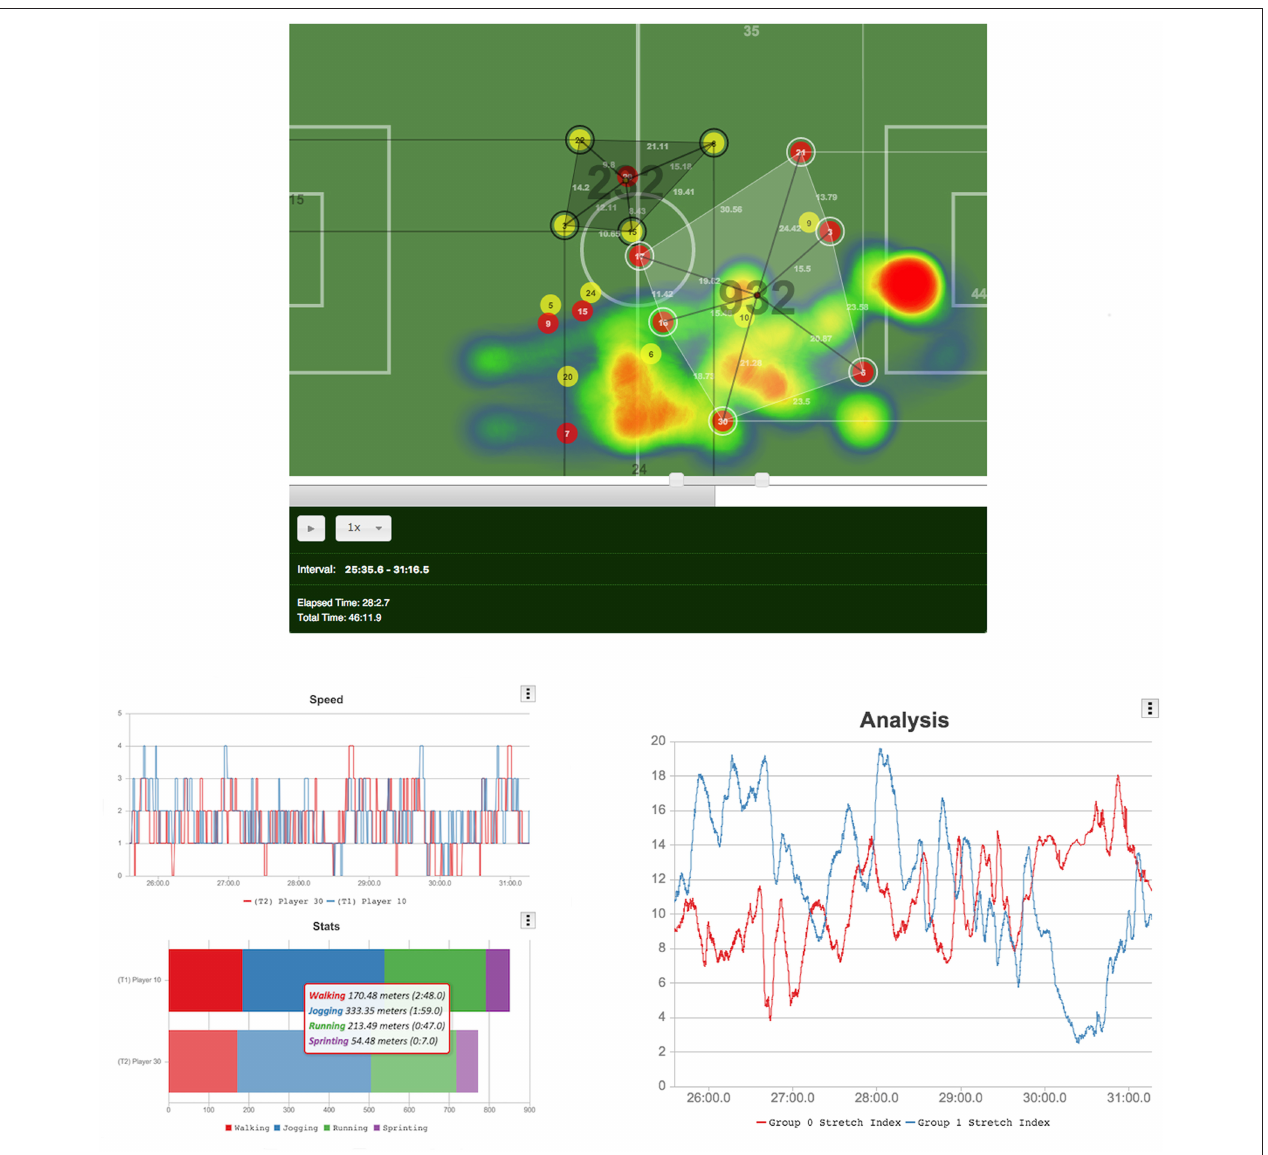
FIGURE 3 | Top: Virtual player and group analysis. Bottom- left : A Comparison in the speed and distance covered by two different players. Bottom- right : Line chart showing the evolution of each group’s stretch index in the selected